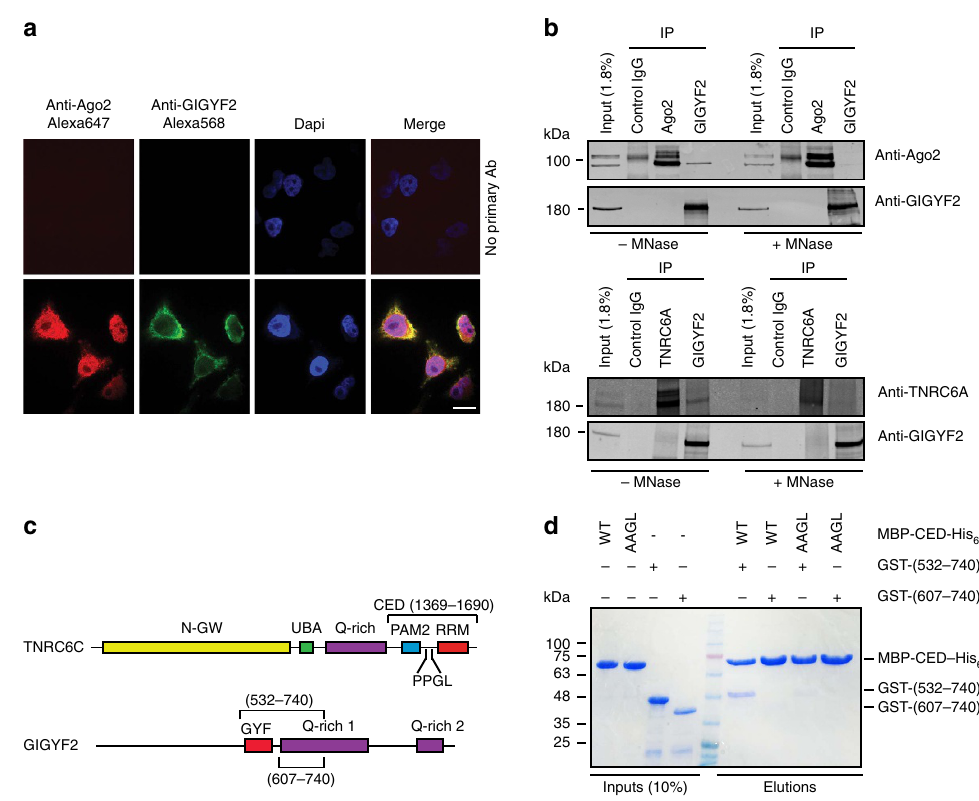
Figure 8 | Identification of a novel miRISC factor. ( a ) Immunofluorescence of endogenous Ago2 and GIGYF2 in HeLa 11ht cells. Scale bar, 15 m m. ( b ) Blots of HeLa cell lysates immunoprecipitated with the indicated antibodies. The blots were decorated with antibodies directed against Ago2, TNRC6A or GIGYF2 as indicated. When indicated ( þ / (cid:2) MNase), lysate were pre-treated with micrococcal nuclease. This panel is representative of three different